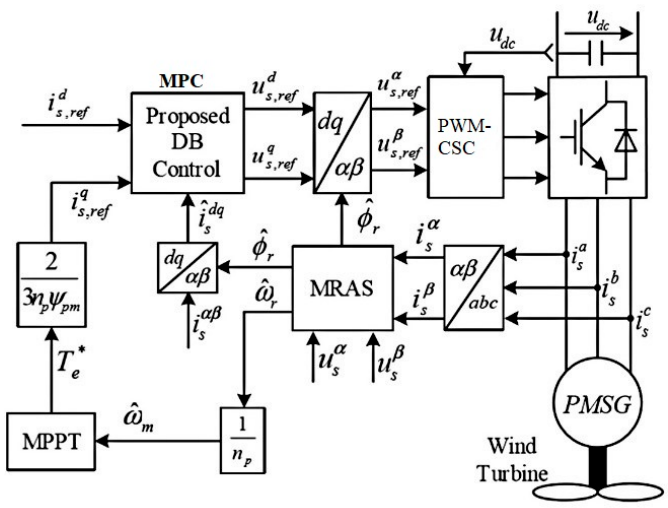
Figure 5. The schematic control diagram of a variable speed wind turbine PMSG.